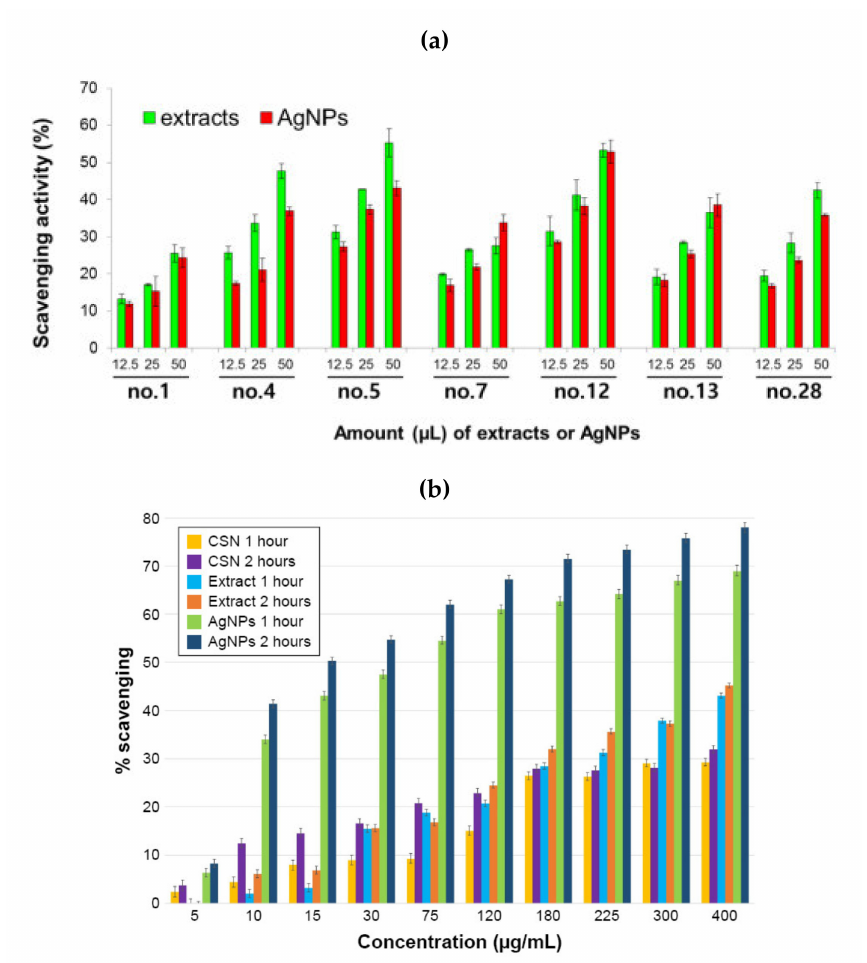
Figure 2. DPPH scavenging activity of ( a ) AgNPs prepared by Chinese plants extract [123], copyright permission by Elsevier; ( b ) AgNPs prepared by walnut green husk extract increasing in concentration and time [124], copyright permission by